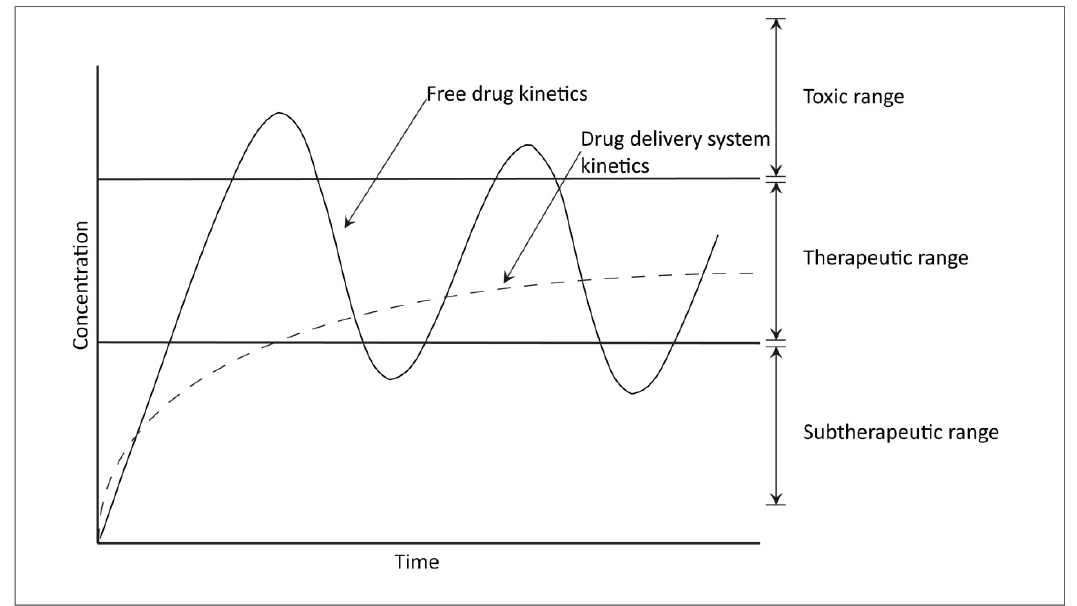
Figure 1. Therapeutic window of administered drugs. The solid line shows the release profile of a repeatedly dosed free drug with a high variation in available drug concentrations ranging from subtherapeutic to toxic levels. The dashed line shows a possible release profile of a drug delivery system which lies within the therapeutic